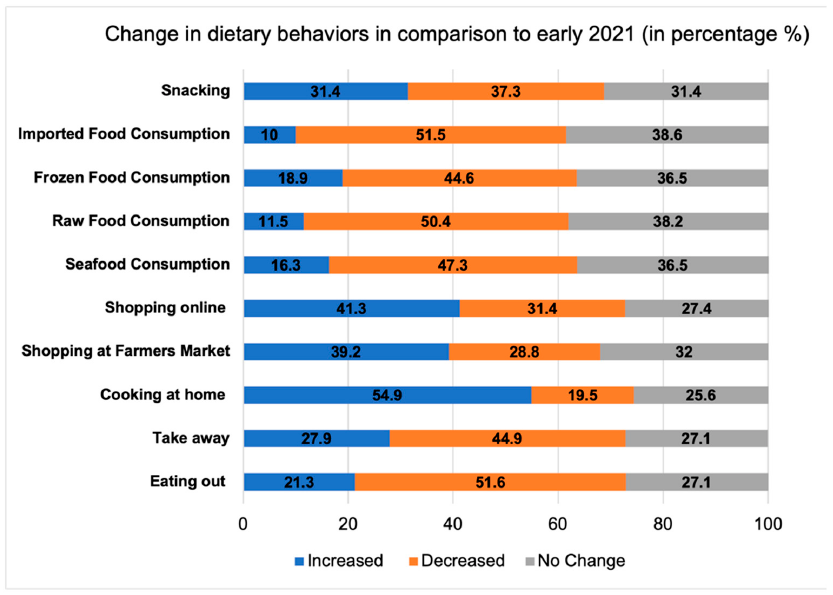
Figure 4. Proportions of people reporting an increase, decrease or no change in dietary behaviors compared to early 2021. Table 4. Changes in dietary behaviors in comparison to early 2021.